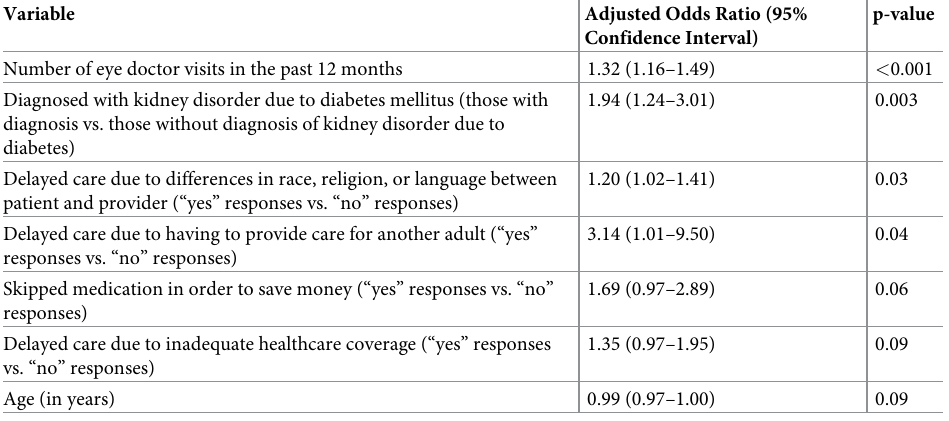
Table 4. Multivariable logistic regression model predicting development of proliferative diabetic retinopathy or related complications among adult patients with diabetic